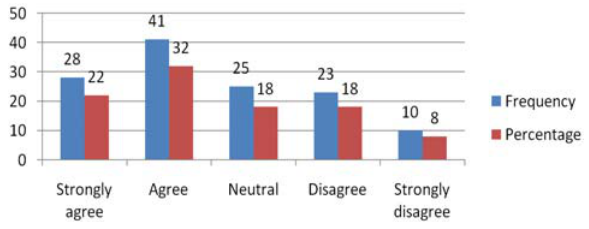
Fig. 3. The level of skills and business growth